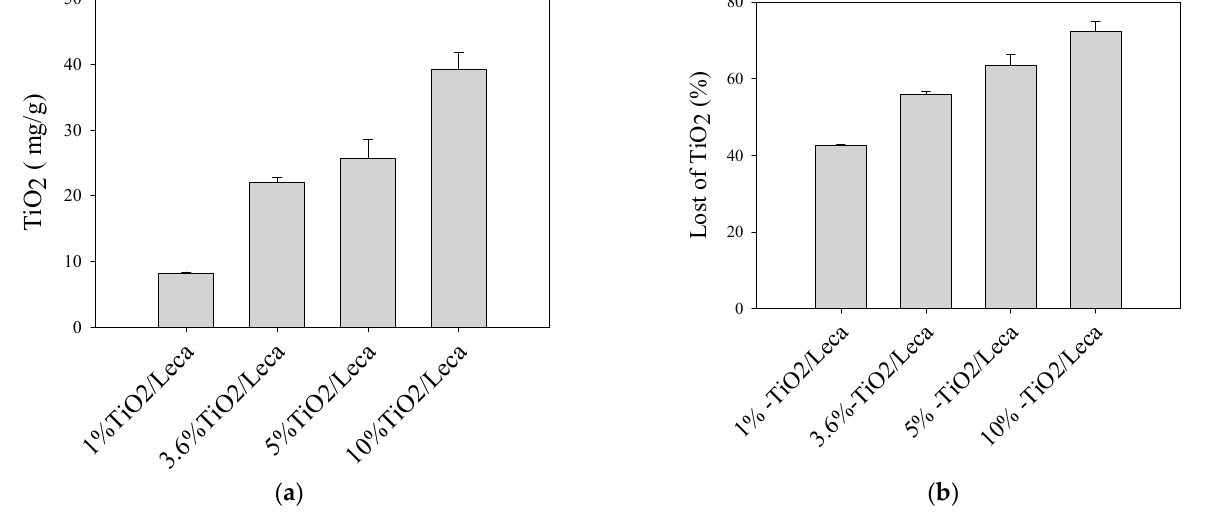
Figure 2. ( a ) Effect of TiO 2 concentration in suspensions on the impregnation of Leca; ( b ) loss of TiO 2 mass for different TiO 2 loads in suspension.